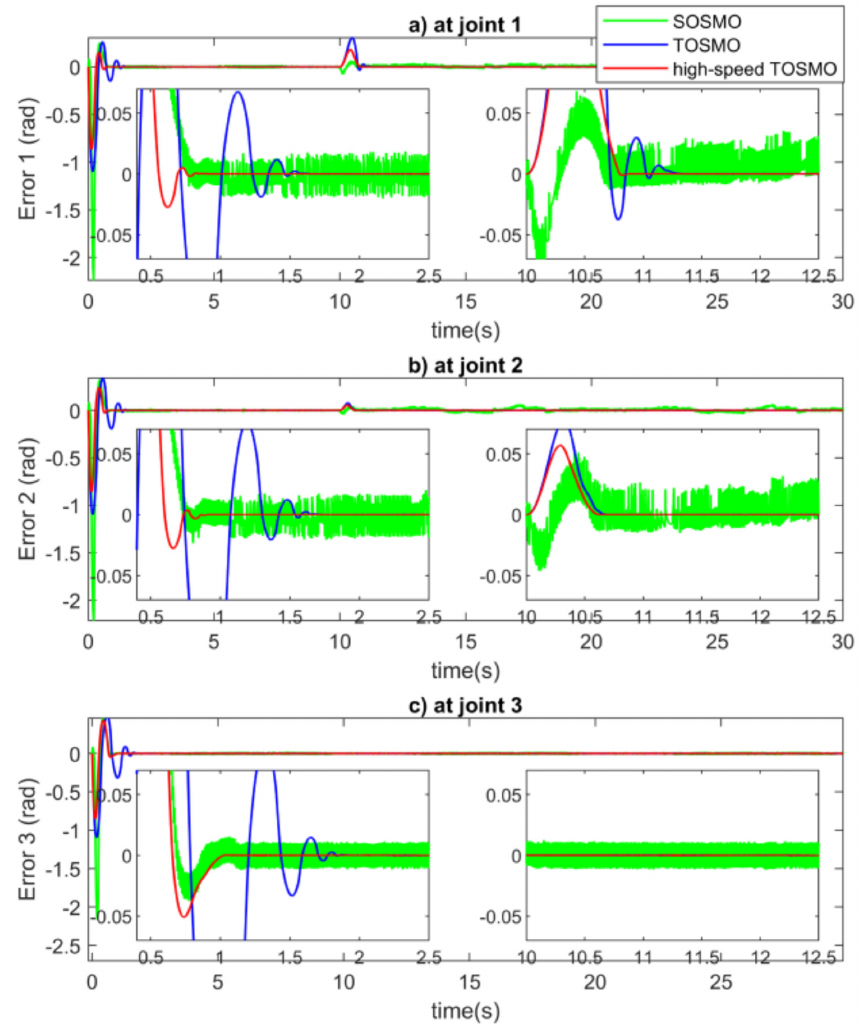
Figure 3. Velocity estimation errors at ( a ) joint 1, ( b ) joint 2 and ( c ) joint